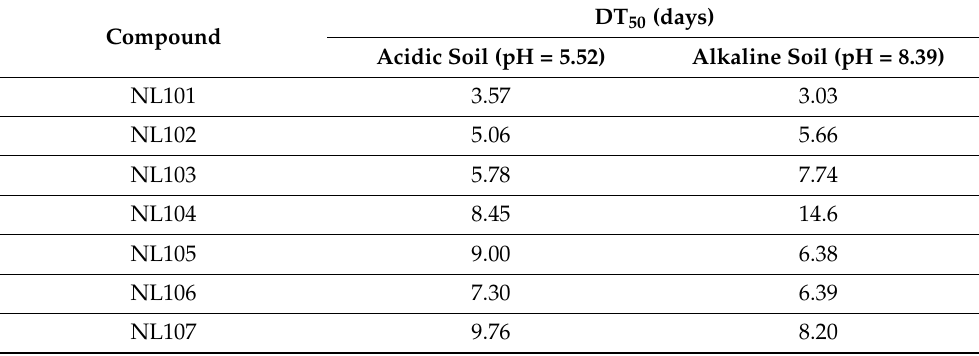
Table 6. Comparison of acidic and alkaline soil degradation results of target